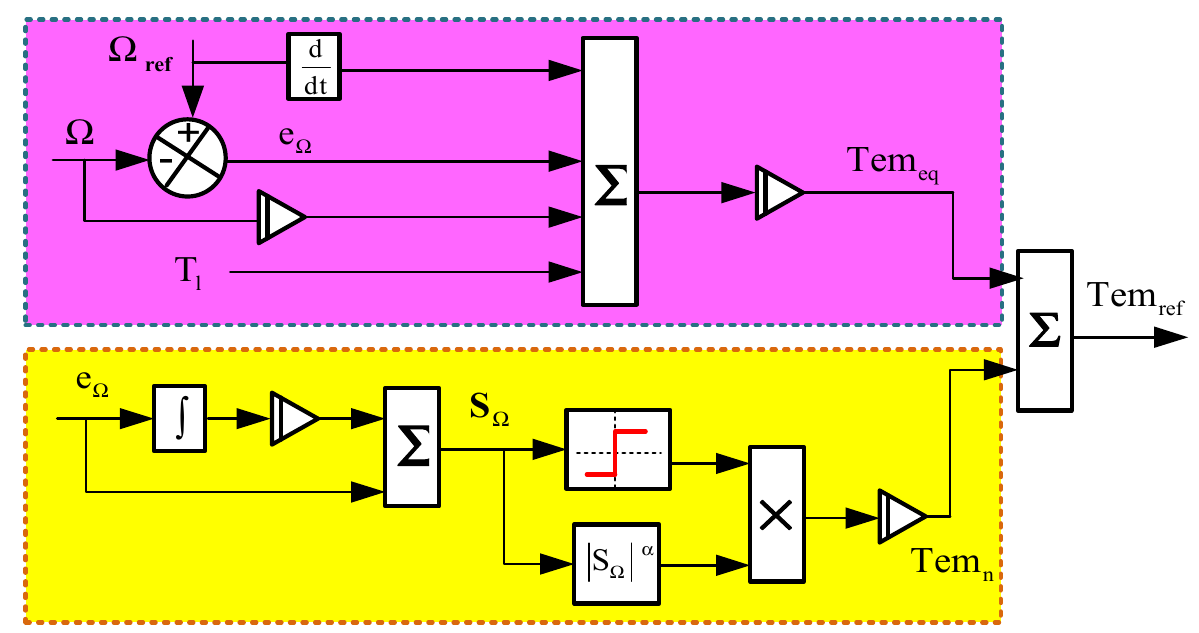
Figure 4. Reference electromagnetic torque generated by the SM speed control loop.